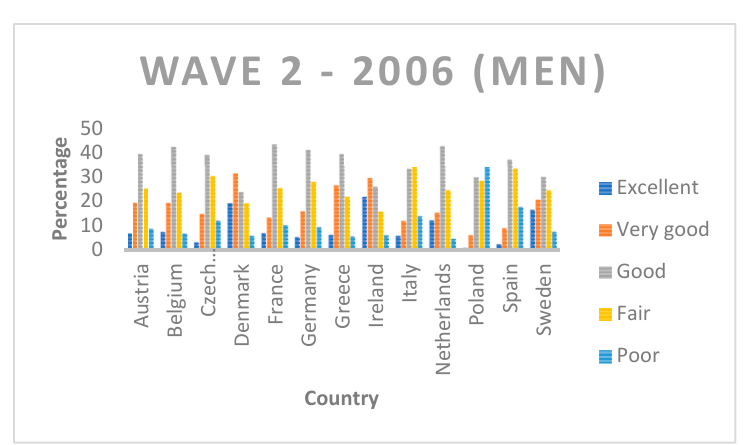
Figure A1. Distribution of men in Wave 2 (2006). Source: Authors’ elaboration based on SHARE (2021).